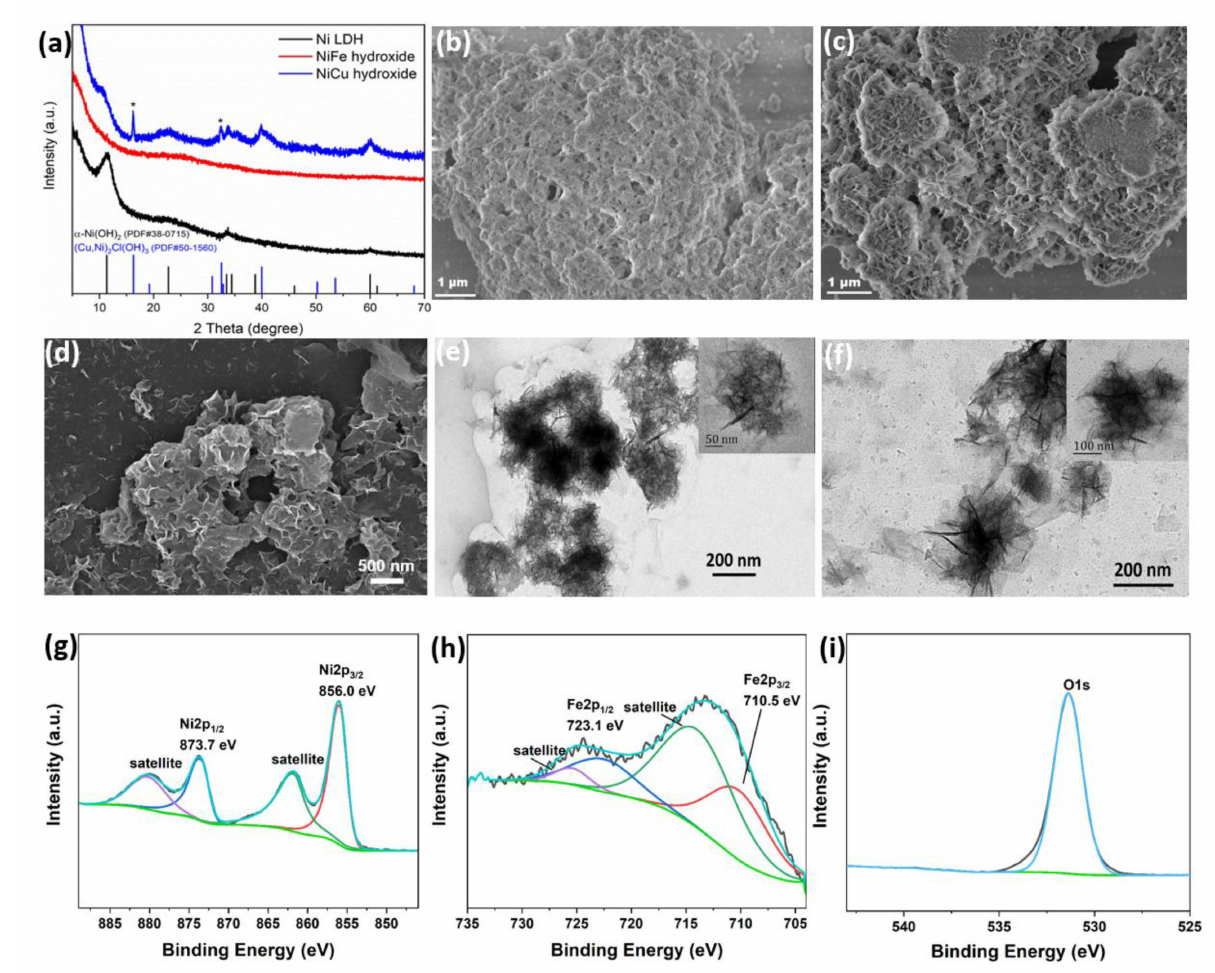
Figure 2. ( a ) The XRD patterns and SEM images. ( b ) NiFe-hydroxide, ( c ) NiCu-hydroxide and ( d ) Ni-LDH TEM images. ( e ) NiFe-hydroxide, ( f ) NiCu-hydroxide, ( g ) Ni 2p, ( h ) Fe 2p, and ( i ) O 1s XPS